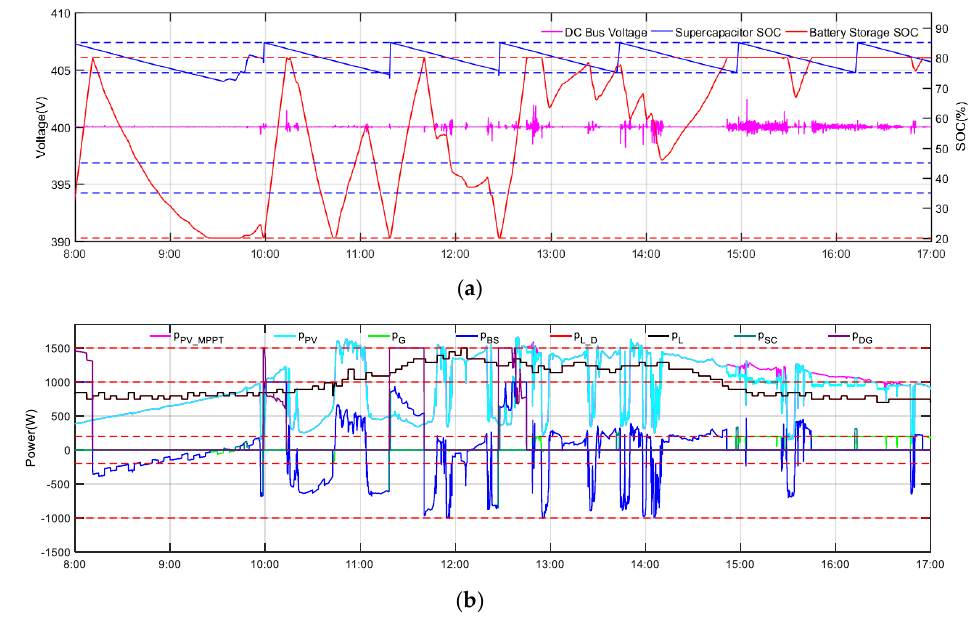
Figure 12. Curves of common DC bus voltage and SOC of storage ( a ) and curves of power ( b ) during